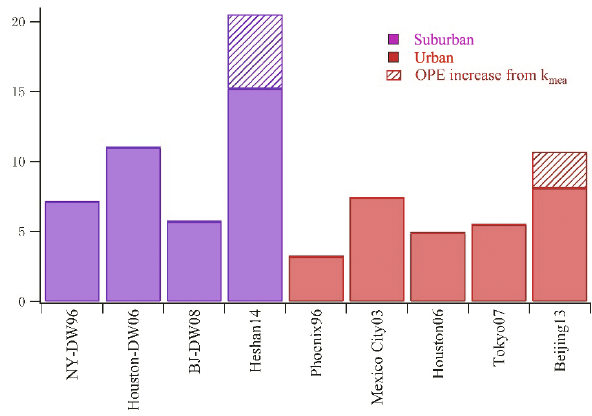
Figure 14. Comparison between the OPE results in this study and other results from the literature. The comparison is made with the NO x = 20ppbV measurement. DW is the abbreviation for down-